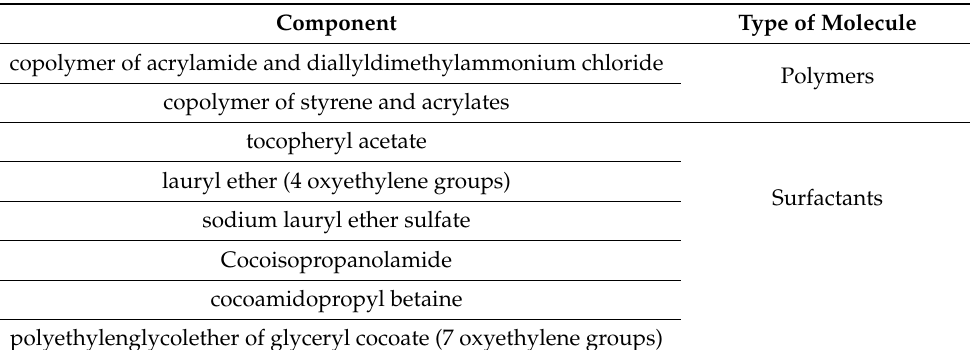
Table 1. Polymer and surfactant contained in a model shampoo according to reference [29].